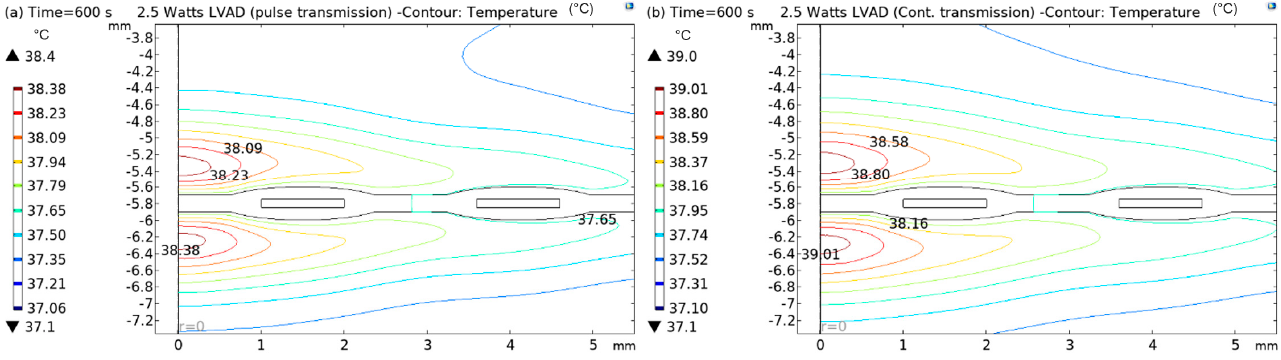
Figure 14. Contour plots of thermal analysis: ( a ) pulsed and ( b ) continuous transmission modes for 5 W LVAD.